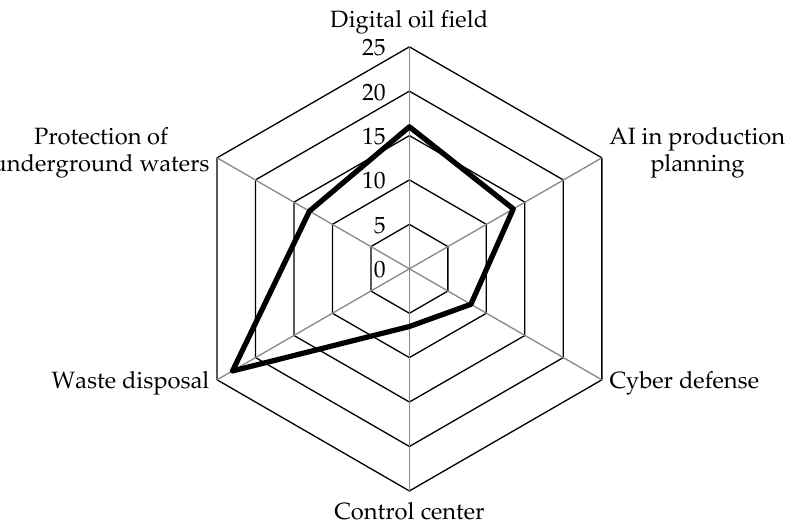
Figure 5. Actual directions of future development of the oil and gas industry.